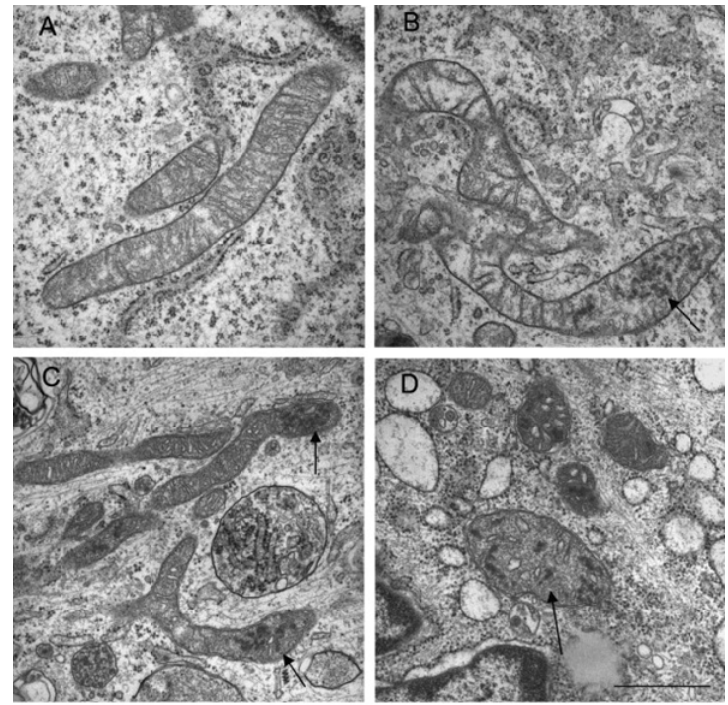
Figure 3. Changes in mitochondrial structure following hydrogen peroxide treatment. (Top panels) Transmission electron micrographs of mitochondria in untreated ( A ) and hydrogen peroxide treated cells ( B , C , D ). Electron dense granules (arrows) and fragmented mitochondria were observed. Bar = 1 μ m. (Bottom panels) Mitochondria were stained with Mitotracker Red and existed as tubular ( A ), intermediate ( B ) (tubular with swollen regions) and fragmented ( C ). Bar = 10 μ